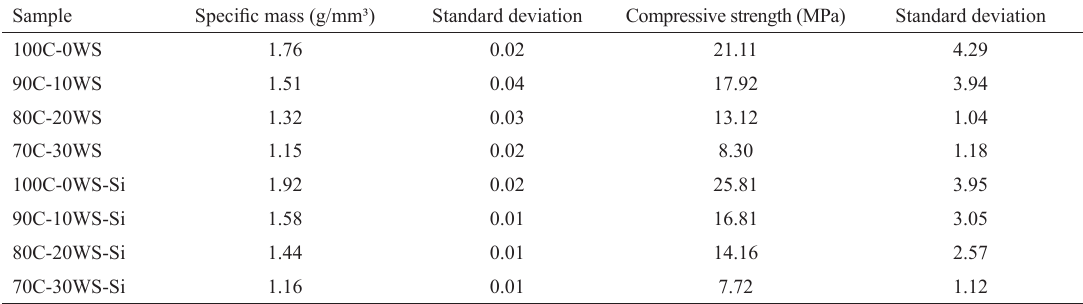
Table 7: Specific mass and compressive strength of calcined aggregates